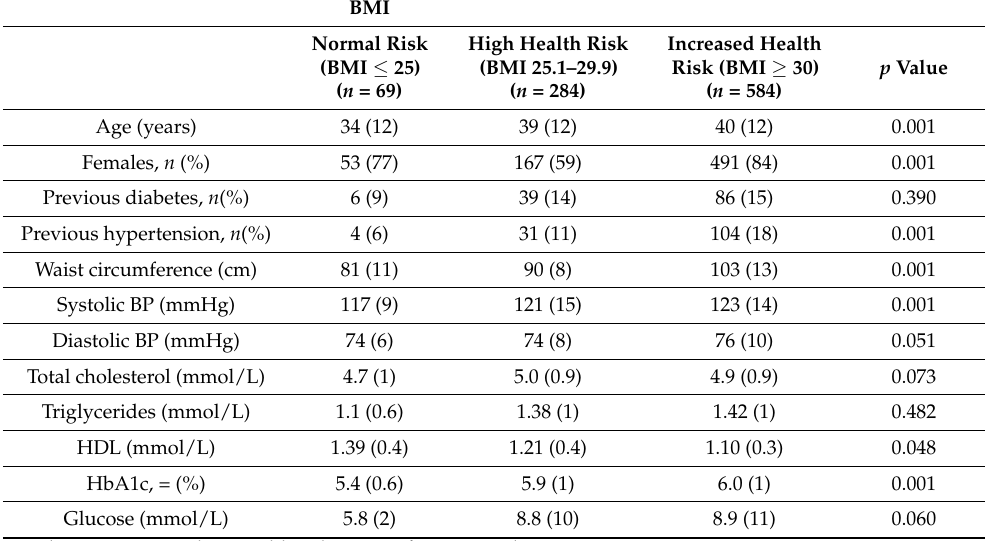
Table 1. Baseline characteristics and metabolic risk factors according to body mass index (BMI) health-risk categories, using the WHO BMI cut-off points, mean (SD).